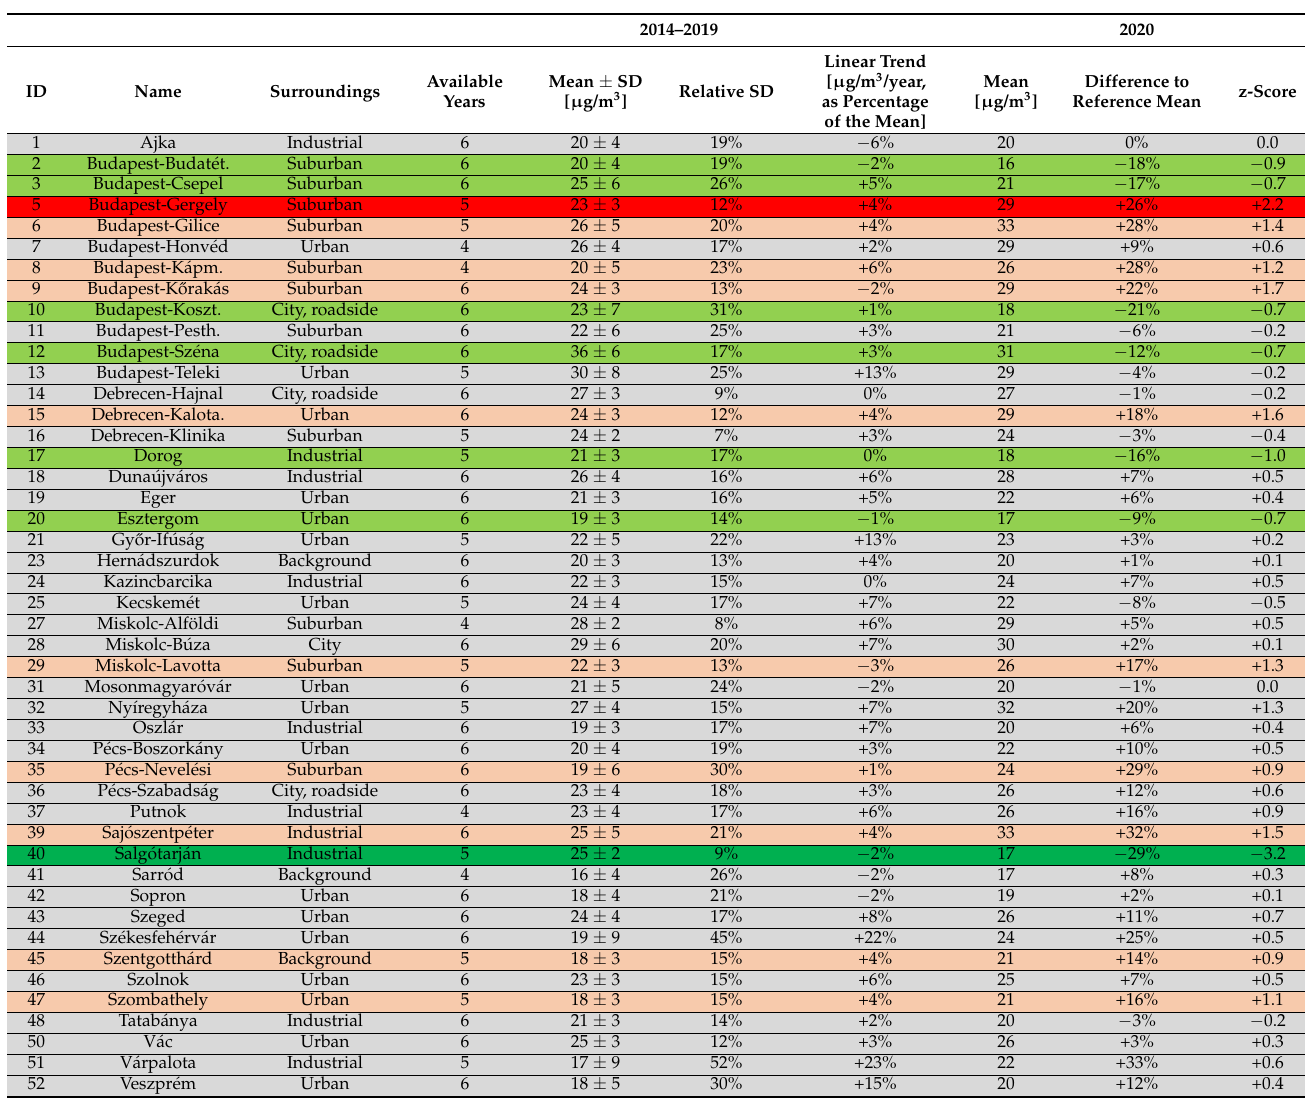
Table A4. Descriptive statistics and changes of PM 10 concentrations measured at Hungarian monitoring sites. Row colors: (light) red—z-score at least +1.96 (+0.67) and the difference to the reference mean is more than 3 year’s linear trend. (light) green—z-score less than − 1.96 ( − 0.67), and the difference to the reference mean is more than 3 year’s linear trend. Gray: absolute value of z-score less than 0.67 OR the difference to the reference mean is less than 3 year’s linear